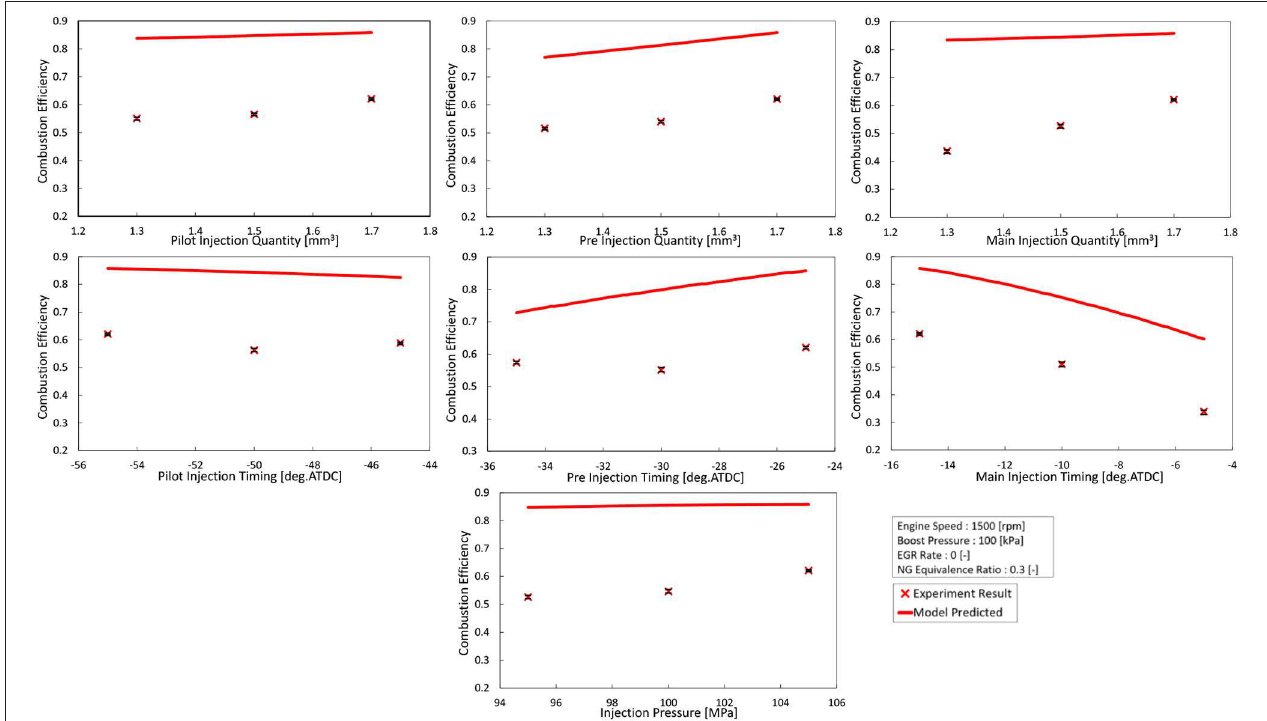
FIGURE 9 | When the injection conditions were changed around the output of the controller.